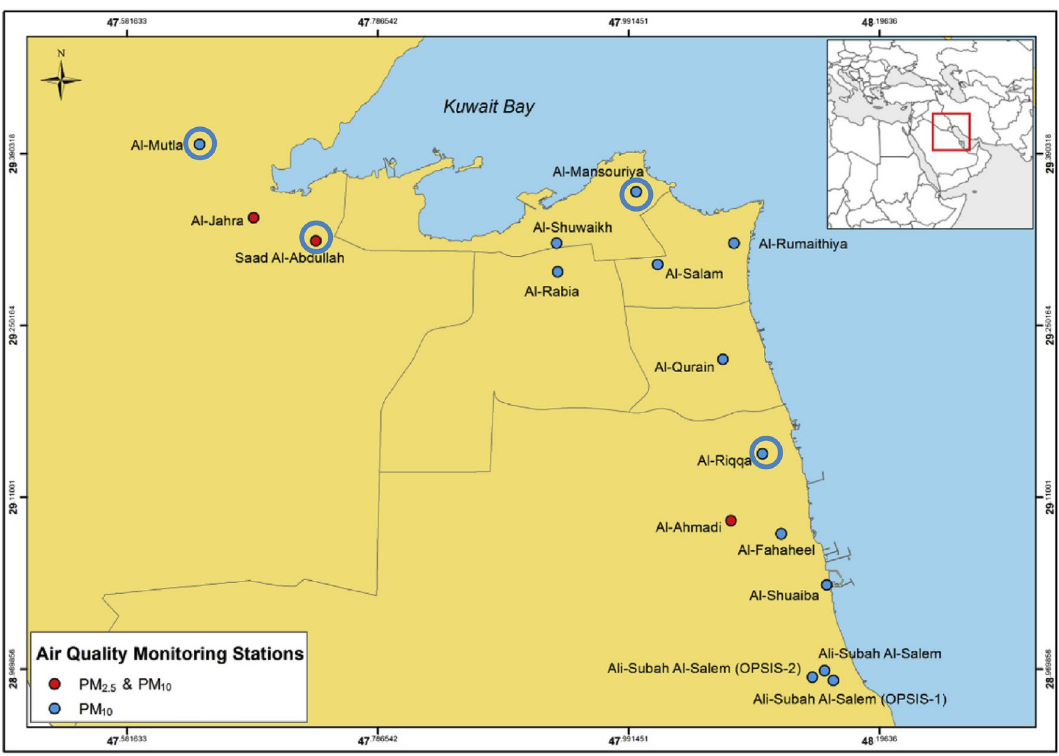
Figure 5. Location of the Kuwait EPA weather stations. The map is reproduced from Al-Hemoud et al. 54 with permission from